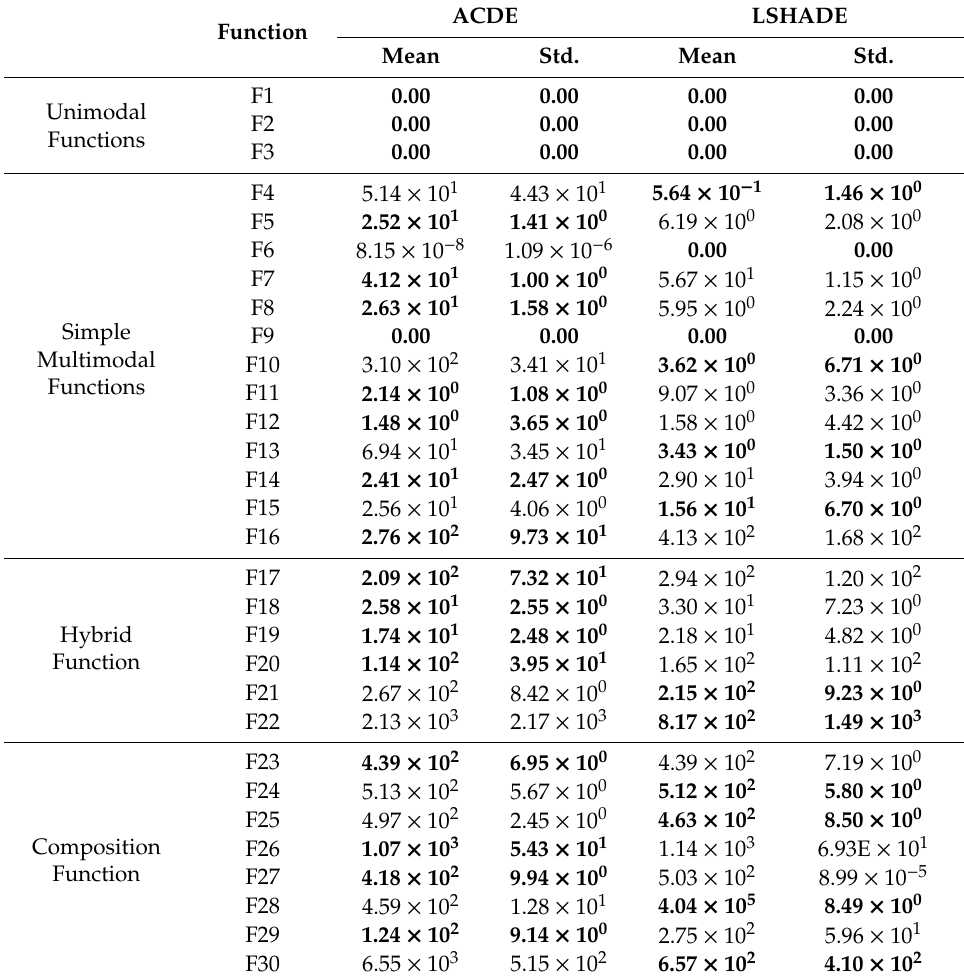
Table 1. Performance comparison of ACDE and LSHADE algorithms of the 50T